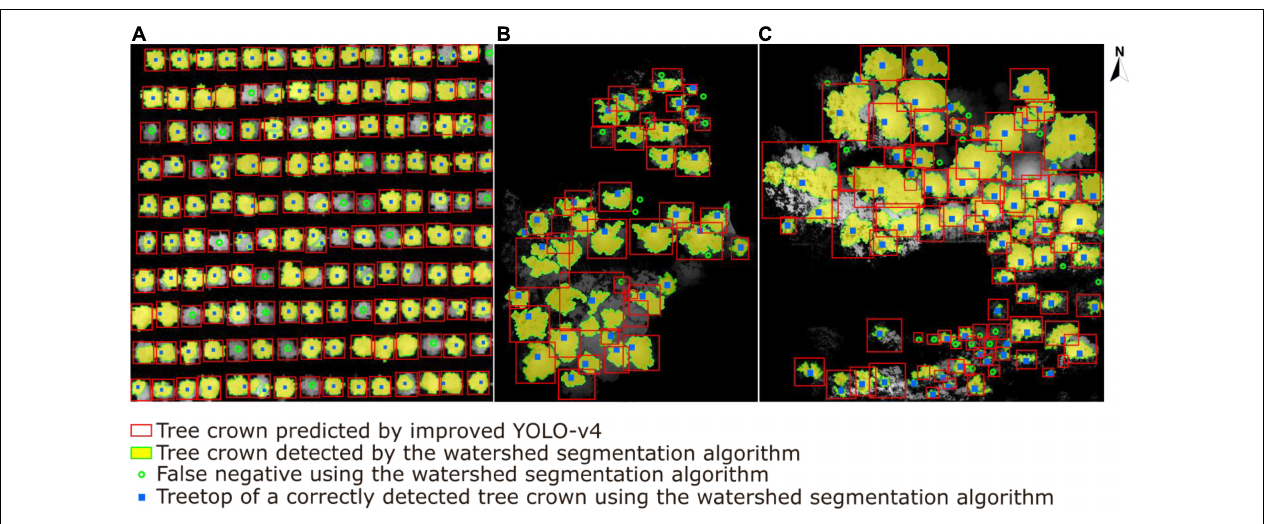
FIGURE 17 | A comparison results of individual tree crown segmentation shown in (A) the tree nursery, (B) the forest landscape area, and (C) the mixed tree habitat using the watershed segmentation algorithm (yellow areas with extracted green boundaries) versus our deep learning algorithm (red boxes). The blue squares represent the correctly detected treetops of tree crowns by watershed segmentation, and the green hollow dots represent the tree crowns missed by watershed